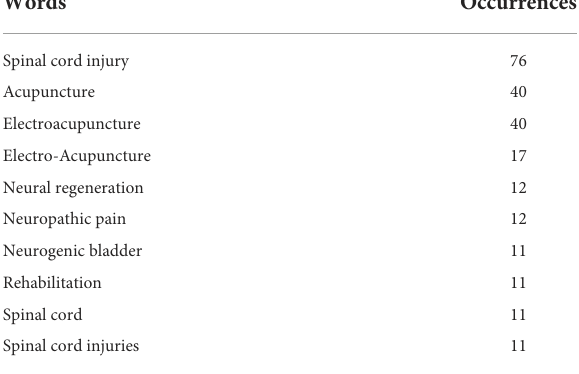
TABLE 4 Top 10 author keywords in the field of acupuncture for